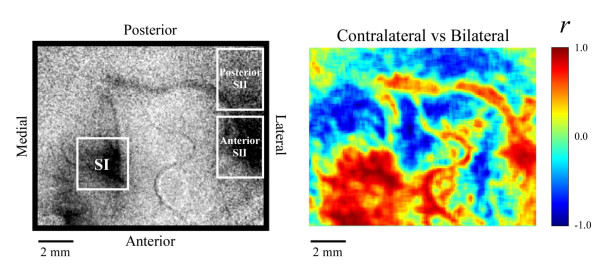
Cross-modal correlation map of Subject #2. Panel at top-left indicates orientation of the correlation map at right. The color bar shows correlation coefficient values used in the map. Correlation coefficients are determined by cross-correlation of time courses evoked at each spatial location to two different stimulus conditions. The map demonstrates that the responses to contralateral and bilateral stimulation are similar in SI and anterior SII, but that the different stimulus conditions evoke a weak or negative correlation in the posterior region of SII. Correlations were performed on data between 1 and 8 sec after stimulus onset.